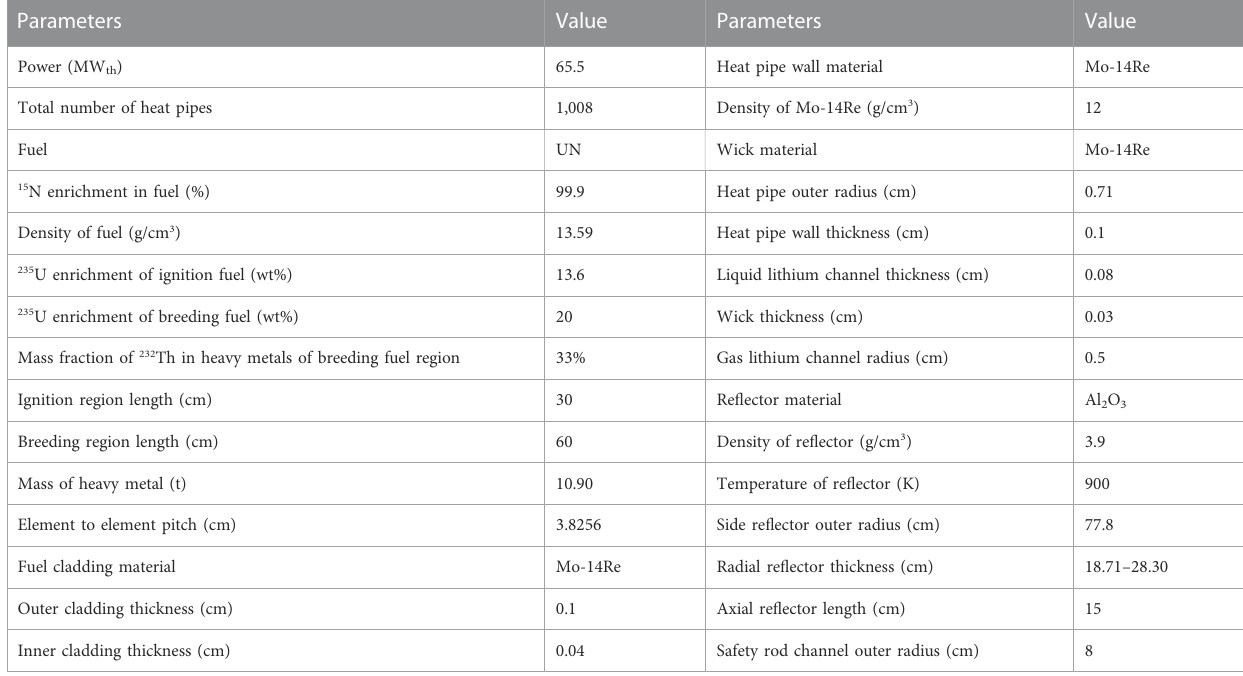
TABLE 1 Main parameters for the HPTWR with Th and U